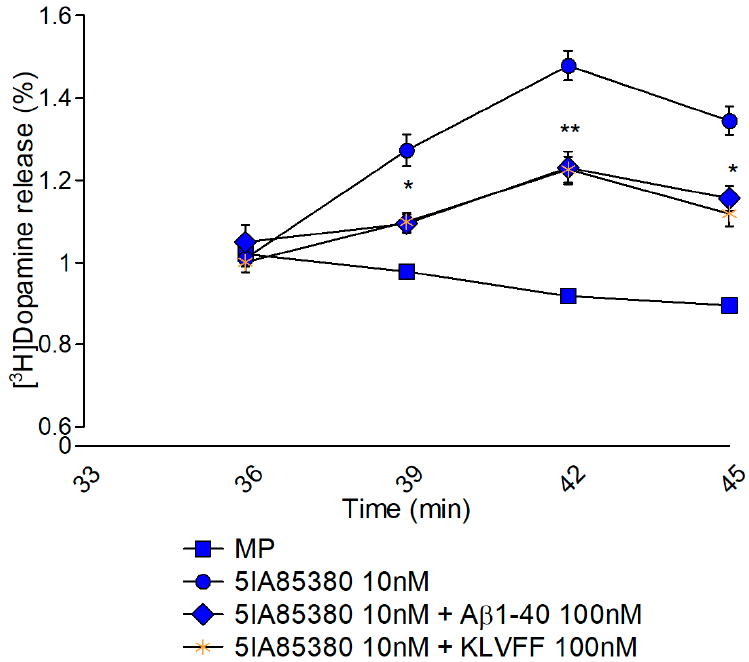
Figure 3. Time course of 5IA85380-induced [ 3 H] dopamine release from striatal synaptosomes in the presence or in the absence of amyloid peptides. The results represent the fractional release obtained in the superfusion protocol. Data are mean ± SEM ( n = 6 per group). * p < 0.05 ** p < 0.01 (compared to MP) two-way ANOVA followed by Tukey’s post hoc test. to MP) two-way ANOVA followed by Tukey’s post hoc